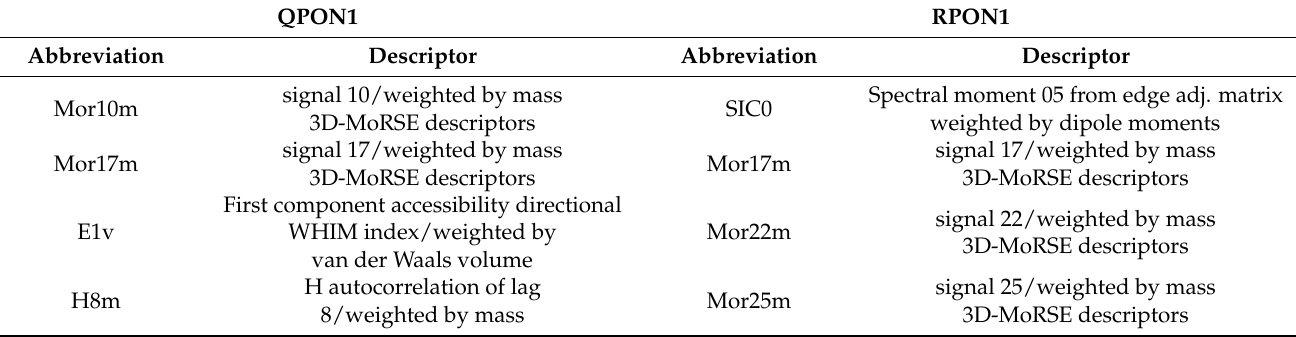
Table 2. Selected molecular descriptors by GA-MLR technique involved in the best models for QPON1 and